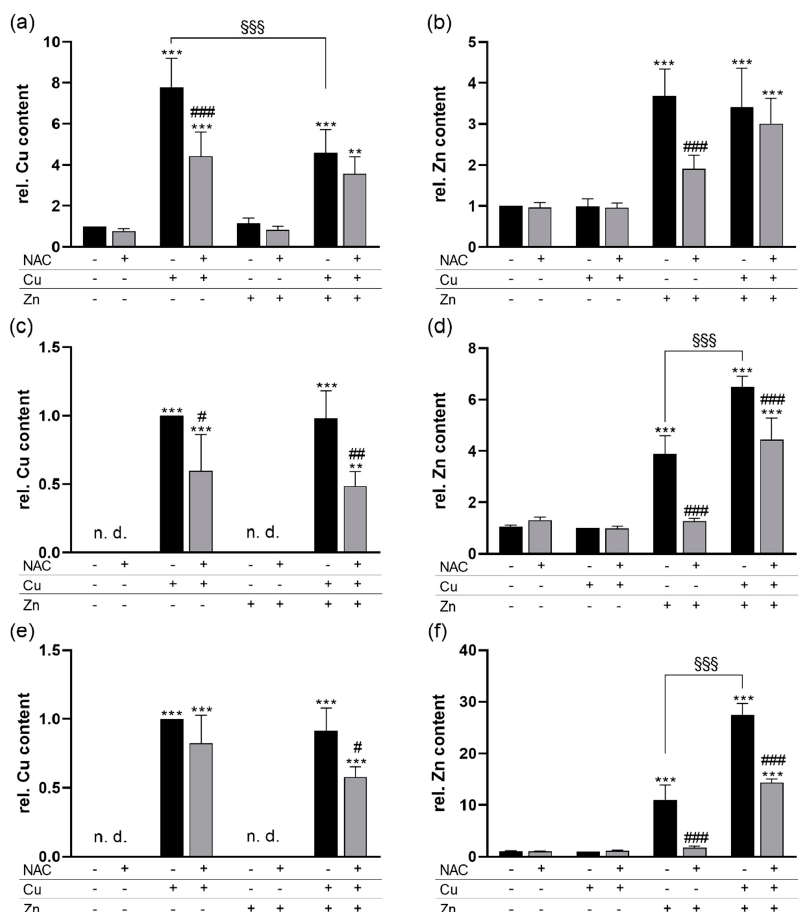
Figure 2. NAC effects on the cellular Cu and Zn content of HepG2, HT-29, and THP-1 cells. Cells were were cultured 6 h with or without 1 mM NAC in combination with 50 µ M CuSO 4 , 50 µ M ZnSO 4 or cultured 6 h with or without 1 mM NAC in combination with 50 μ M CuSO 4 , 50 μ M ZnSO 4 or both. both. The ( a , c , e ) Cu and ( b , d , f ) Zn content was measured using total reflection X-ray fluorescence (TXRF) spectroscopy in HepG2 ( a , b ), HT-29 ( c , d ), and THP-1 ( e , f ) cells. Results are depicted as